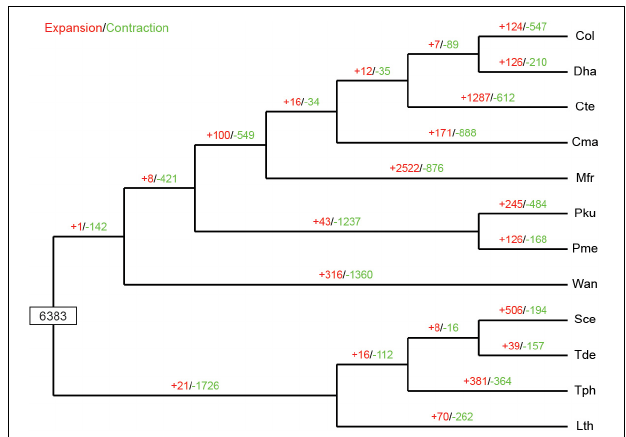
FIGURE 5 | Expansion and contraction of gene families among the 12 yeast species. Phylogenetic tree was constructed based on 538 high-quality 1:1 single-copy orthologous genes. The numerical values on each branch of the tree represent gene families undergoing gain (red) or loss (green) events. Gene families predicted in the most recent common ancestor (MRCA) was 6,383. Three-letter acronym for the abbreviation of each species name.